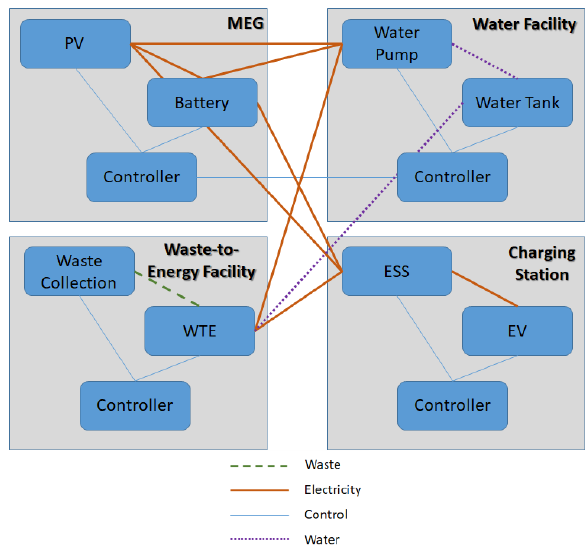
Figure 3. Example of HES within interconnected infrastructures.